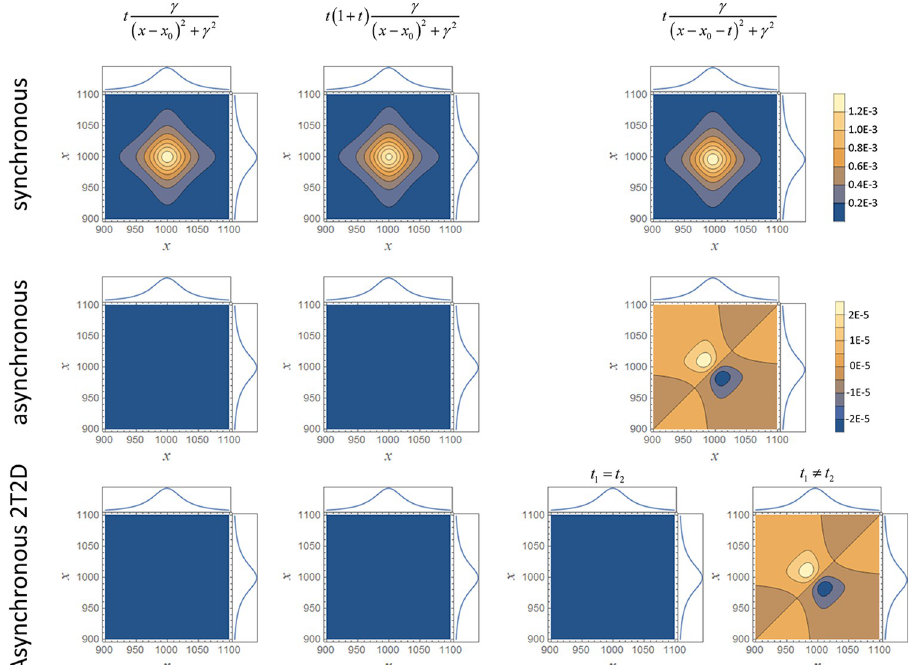
Fig 2. 2D-Correlation maps of Cauchy-type functions. Comparison of the hybrid synchronous and asynchronous maps of the Cauchy-type functions used in this work ( Y 1 = Y 2 ).